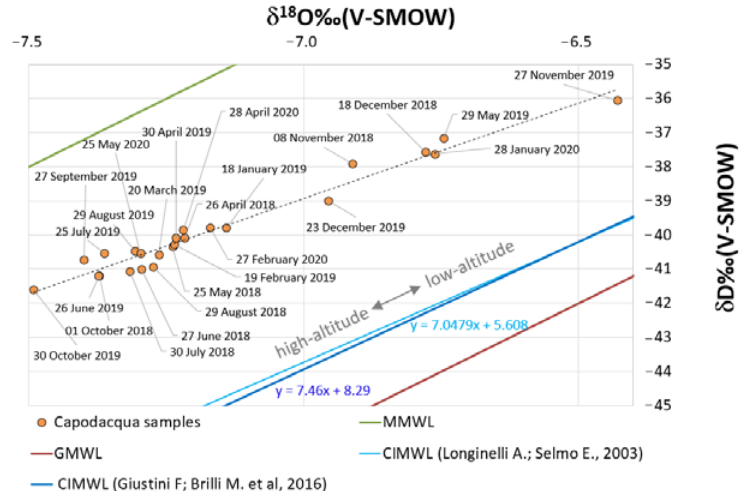
Figure 8. Plot of δ 2 D vs. δ 18 O for Capodacqua di Spigno samples.